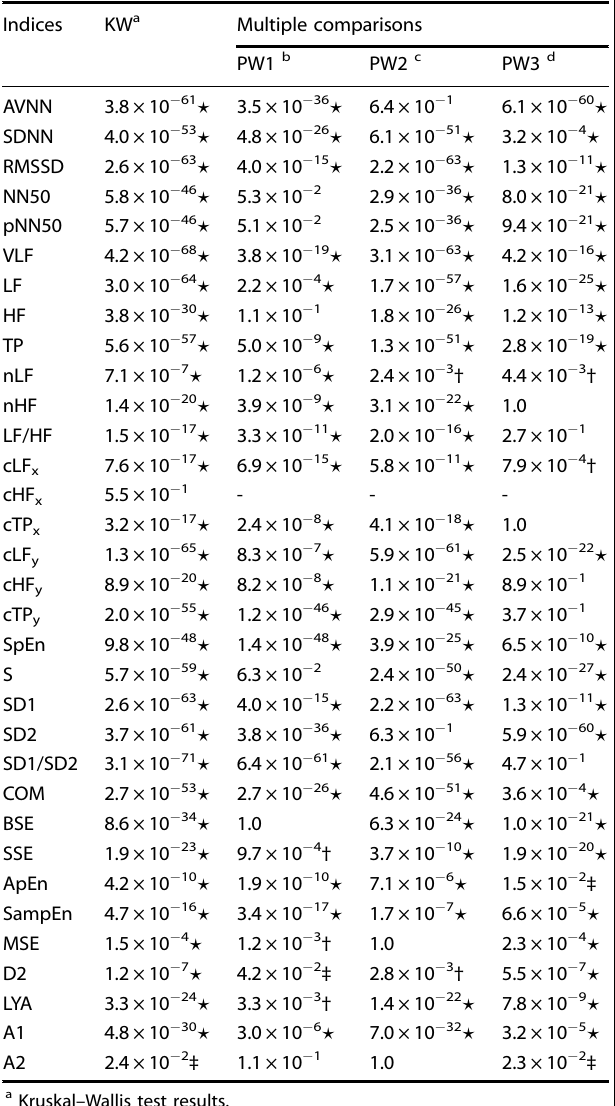
Table 5. Kruskal – Wallis and post hoc multiple comparisons p values for the comparison among blood pressure states from indices measured from heart rate variability. ‡ : p value less than 5.00 × 10 − 2 ; †